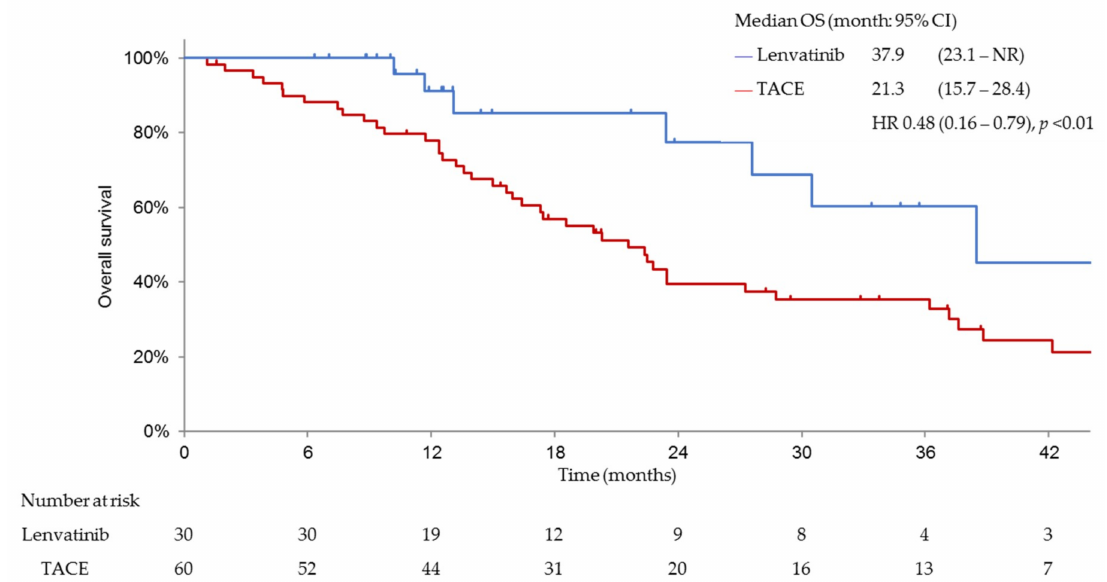
Figure 4. Overall survival (OS) in both groups after propensity score matching. OS in the lenvatinib-treated group was significantly better than that in the TACE-treated group (37.9 months vs. 21.3 months; hazard ratio (HR)0.48, p < 0.01). NR; not